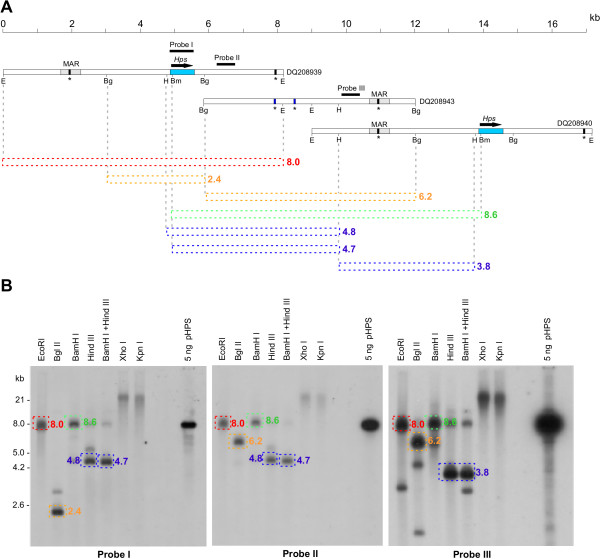
An analysis of Hps genomic clones. A, Three independent clones isolated from soybean (Glycine max cv. Harosoy 63) genomic libraries are illustrated, along with their GenBank accession numbers. Shown for each clone are: blue box, location of the Hps gene; arrow, direction of transcription; Bm, Bg, E, and H, restriction enzyme sites for BamHI, BglII, EcoRI, and HindIII, respectively; MAR, predicted matrix attachment regions; * (asterik), location of micro-satellite dinucleotide AT repeats; Probe I, Probe II, and Probe III, correspond to DNA sequence fragments used to probe genomic DNA blots shown in the lower part of the figure. The three clones are aligned with overlapping regions of nearly identical DNA sequence. The predicted restriction enzyme fragments and their corresponding size (kb) are shown in colour directly below the genomic clones. B, Soybean (Glycine max cv. Harosoy 63) genomic DNA blot hybridizations using three different DNA probes, Probe I, Probe II, and Probe III. Samples of 20 μg of soybean genomic DNA were digested with the indicated restriction enzymes. A 5 ng sample of a plasmid (pHPS) carrying a genomic clone encoding Hps (GenBank accession number DQ208939) was digested with EcoRI, and included as an internal hybridization standard. The DNA samples were separated by agarose gel electrophoresis and blotted to Nylon membrane, prior to hybridization to each of 32P labelled DNA probes (with stripping between hybridizations). Coloured boxes and sizes (kb) of the most intense hybridizing fragments are indicated, and were matched to the predicted restriction enzyme fragments from the alignment of the genomic clones, shown in the upper part of the figure. The migration of DNA markers and their size (kb) are shown on the left.